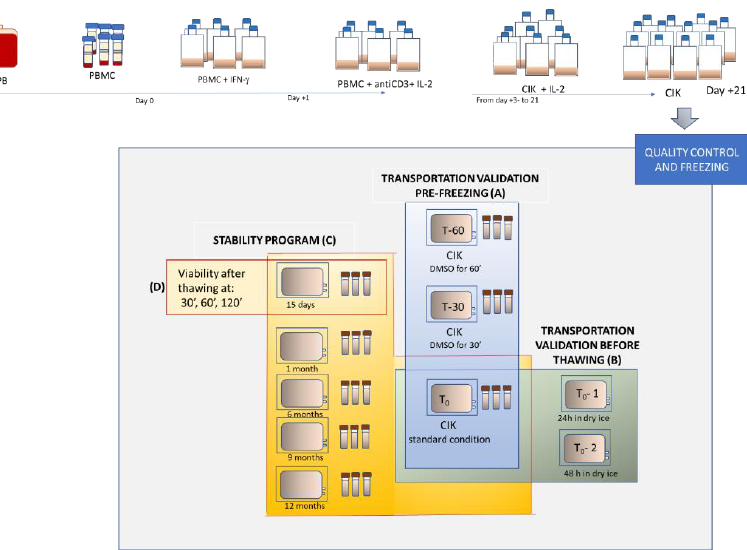
Figure 1. Study design scheme.